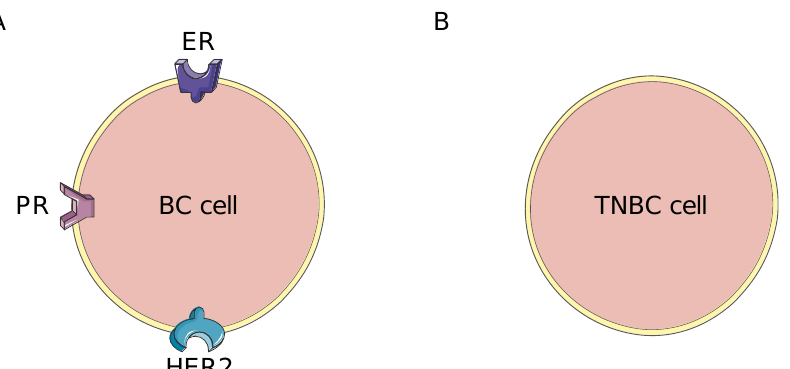
Figure 1. The lack of expression of receptors in triple-negative breast cancer. ( A ): Most breast cancer cells express estrogen receptor, progesterone receptor and human epidermal growth factor receptor 2. ( B ): Triple-negative breast cancer lacks the expression of these receptors. BC: Breast cancer; ER: Estrogen receptor; PR: Progesterone receptor; HER2: Human epidermal growth factor receptor 2; TNBC: Triple-negative breast cancer.